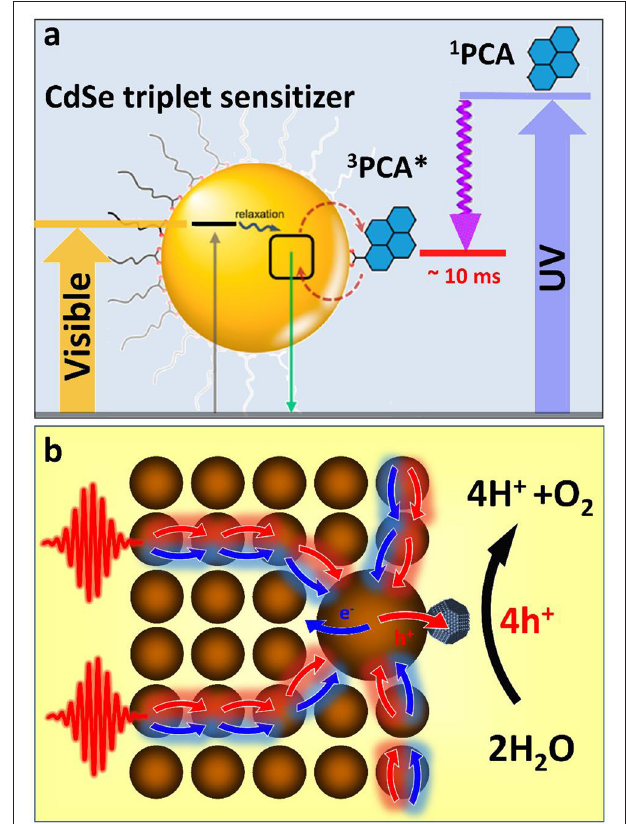
FIGURE 2 | (a) Triplet sensitization of 1-pyrenecarboxylic acid (PCA) molecular acceptor by CdSe NCs via photoinduced triplet–triplet energy transfer